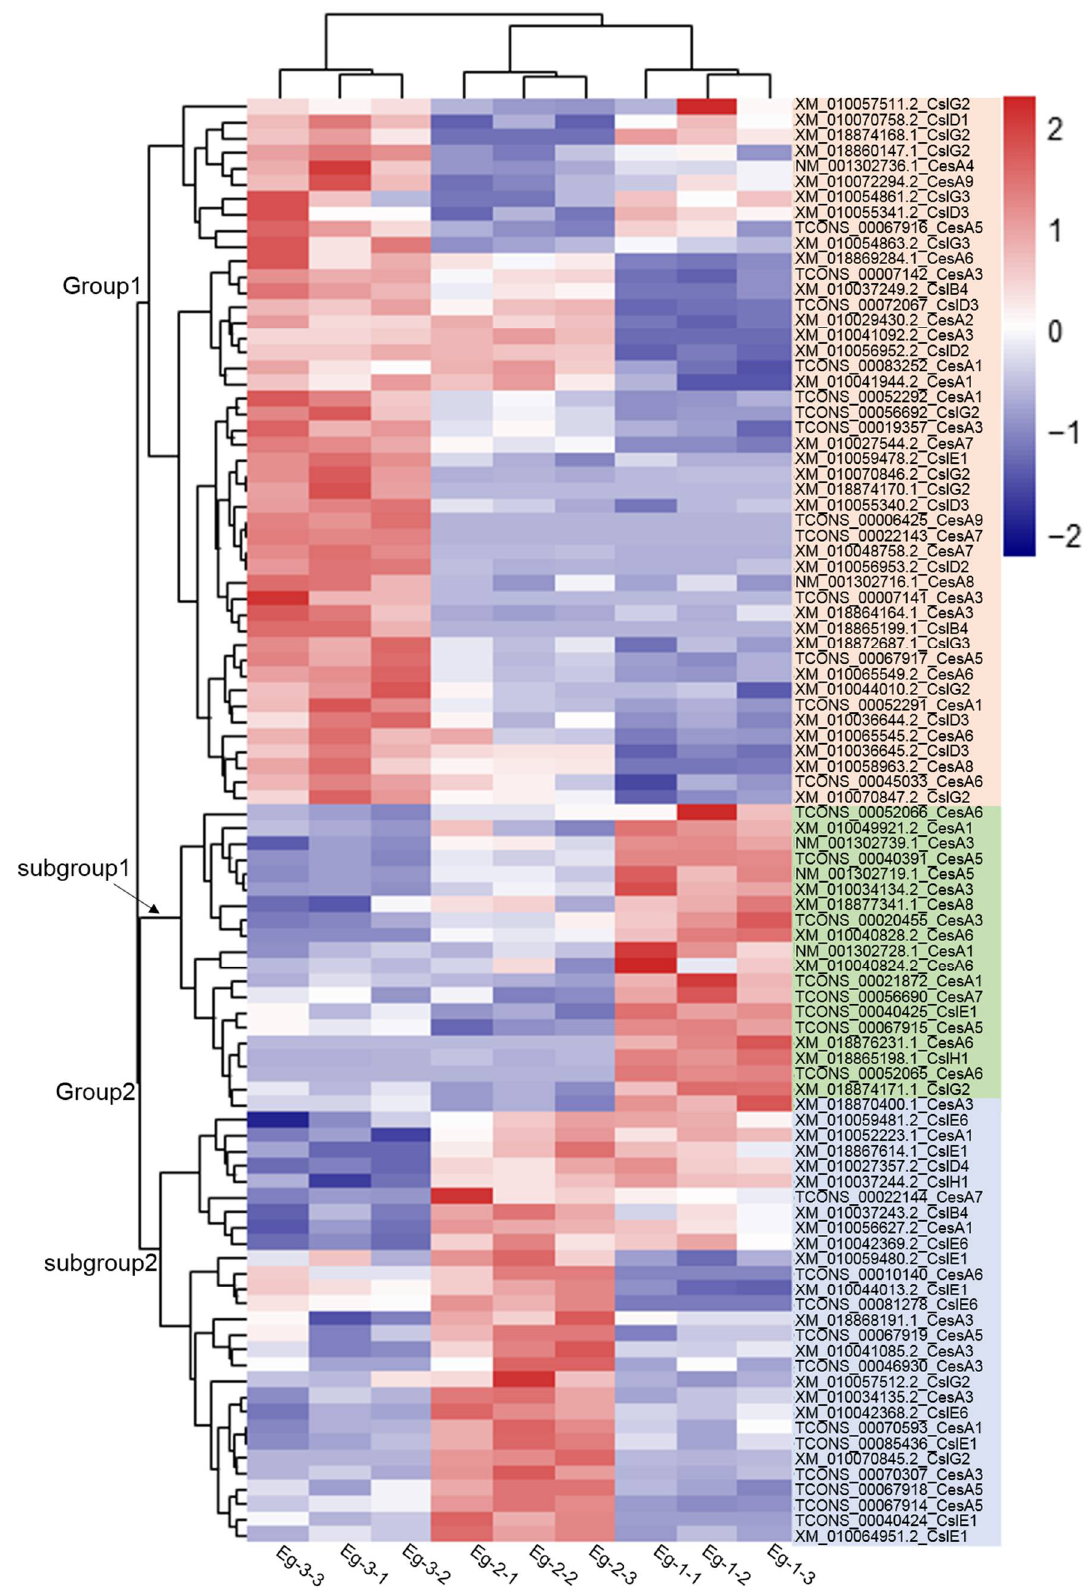
Figure 5. Heat map of expression levels (FPKM) of 100 transcripts of CS in the three different parts of E. grandis. Note: the color scale indicating the level of expression of unigenes—deeper red indicates higher expression, while greener colors represent a lower expression .